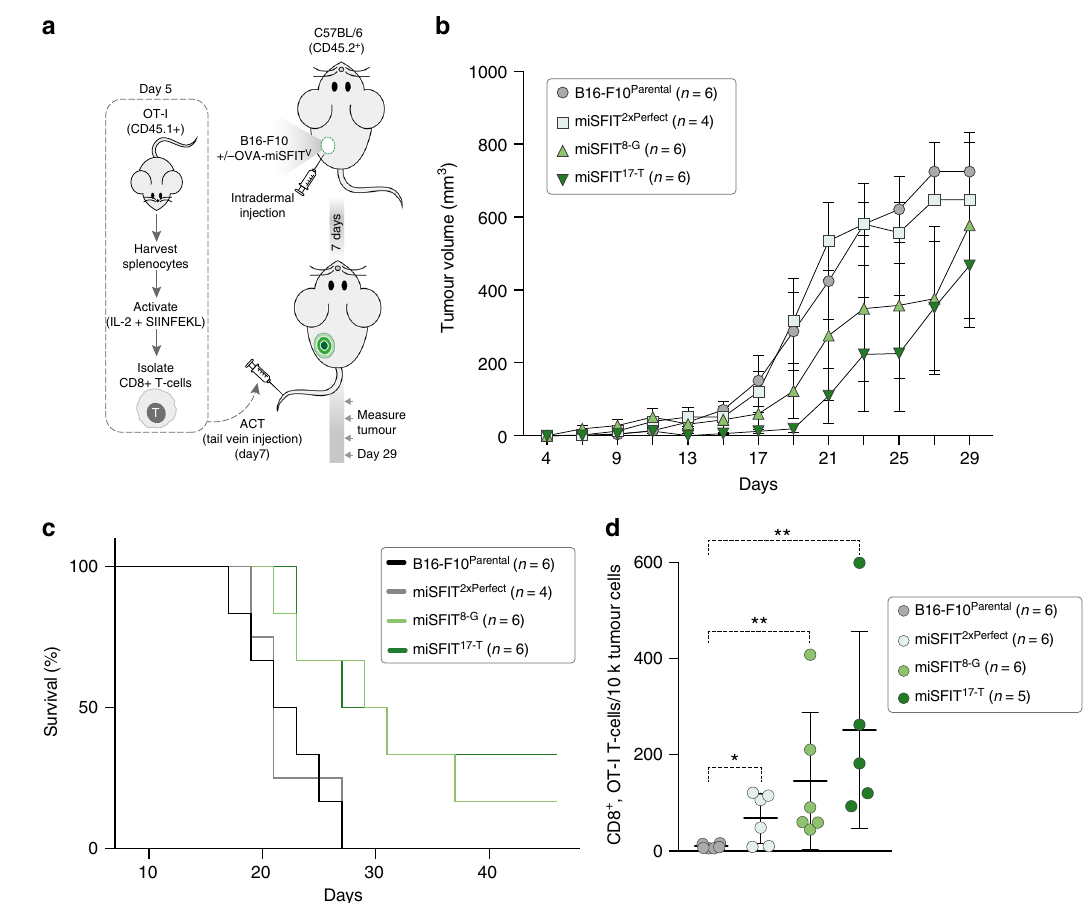
Fig. 4 Antigen expression levels determine the anti-tumour immune response in vivo. a Experimental design for in vivo OVA-miSFIT B16-F10 tumour growth experiments. b Analysis of tumour volume over time for four B16-F10 cell lines (3 OVA-miSFIT variant lines and one B16-F10 parental control line) challenged with OT-I CD8 + T-cells ( x -axis = number of days from tumour cells injection; mean + / − s.e.m.) c Survival curves for mice injected with B16- F10 lines following the same experimental setup as in a . d Frequency of CD8 + , OT-I TILs per tumour (mean + / − s.d., Mann – Whitney U -test, * P < 0.05, ** P < 0.01). For experimental setup see Supplementary Figure 8. Source data are provided as a Source Data fi